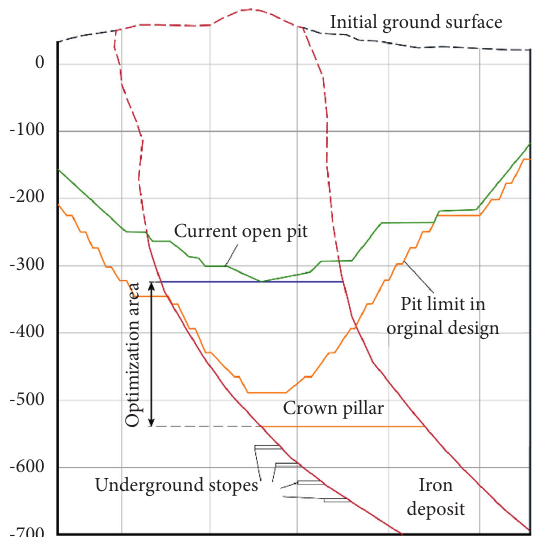
Figure 4: Cross-section of deposit in the Dagushan iron mine for optimizing surface-to-underground mining transition. Table 1: Rock property for modifying the size of the crown pillar by the beam model. ρ (t · m − 3 ) σ c (kPa) k l (m − 1 ) 4.1 77.84 3